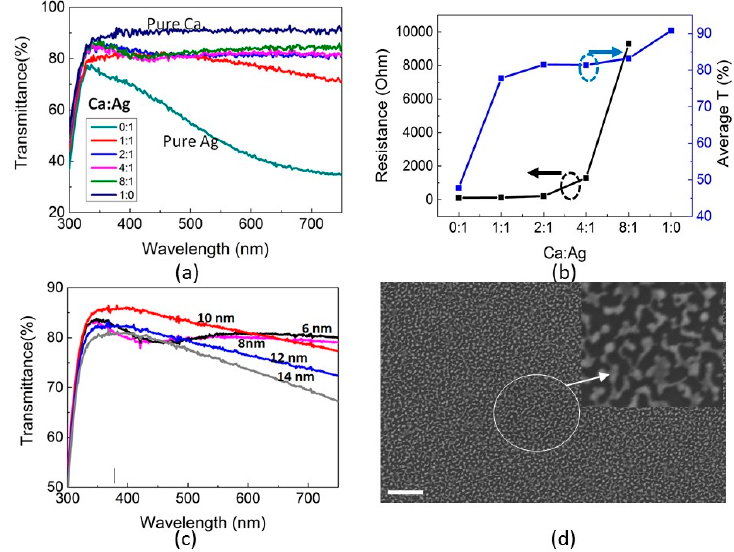
Figure 5. ( a ) Transmittance spectra of pure Ca, pure Ag, and the Ca:Ag electrode. ( b ) Average transmittance of the visible region and sheet resistance of the Ca:Ag electrode. ( c ) Thin film transmittance of the Ca:Ag electrode with various thickness. ( d ) Atomic-force microscopy (AFM) image of 10 nm Ca:Ag thin film. The scale bar is 1 µm.